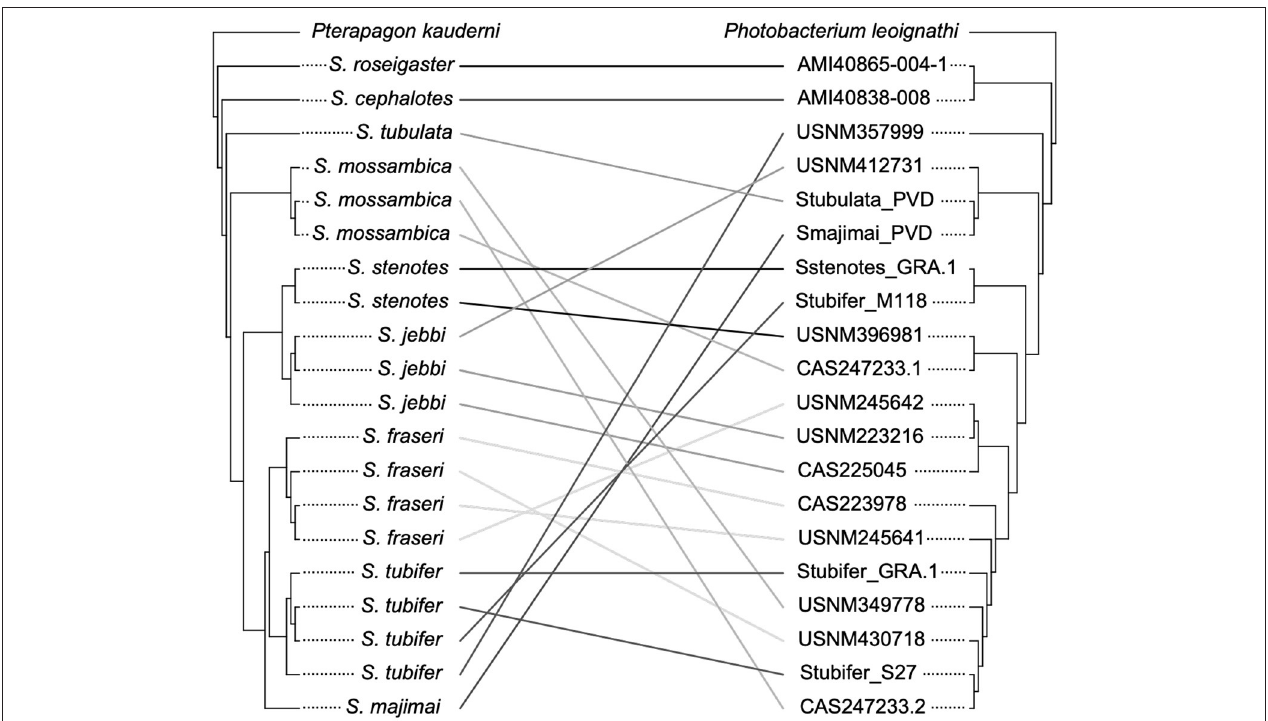
FIGURE 5 | Analysis of the phylogenetic relationships of Siphamia hosts (left) and their light organ symbionts (right) revealed no evidence of co-divergence. The host cladogram is based on COI gene sequences and the symbiont cladogram is based on a core set of 1,471 single nucleotide polymorphisms. Linkages between individual hosts and their symbionts are shown and colored according to host